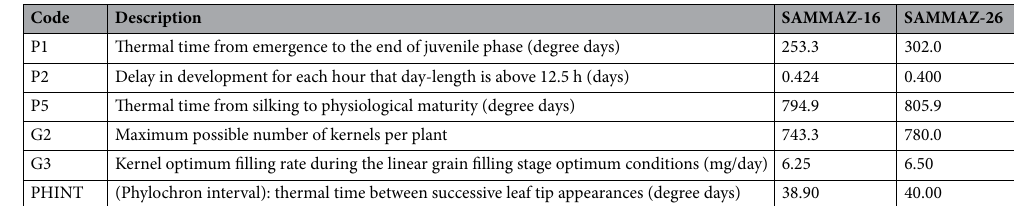
Table 1. Genetic coefficients for SAMMAZ-16 and SAMMAZ-26 maize varieties used in the study (coefficients for SAMMAZ-16 were adapted from Tofa et al. 55 ).